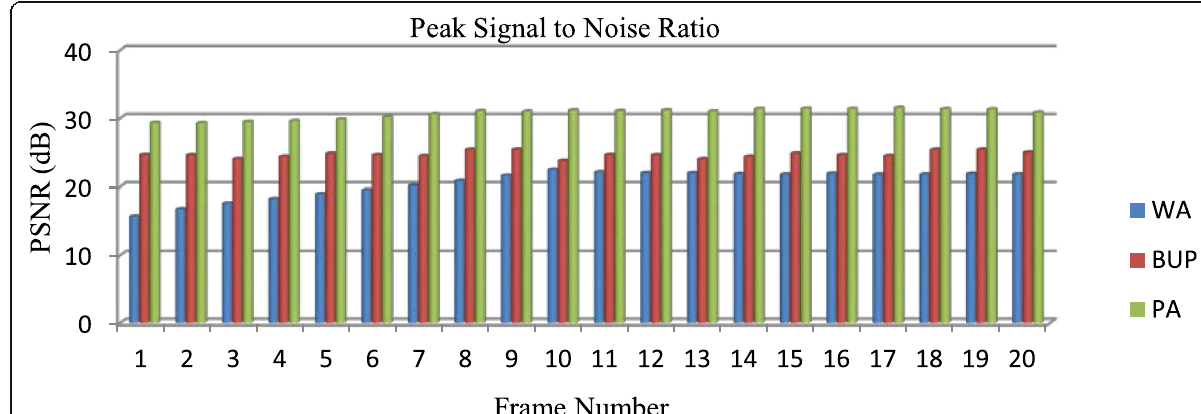
Fig. 6 The PSNR measurement. The PSNR were measured across selected frames corresponding to the proposed method, and the result is plotted against the existing BUP and WA